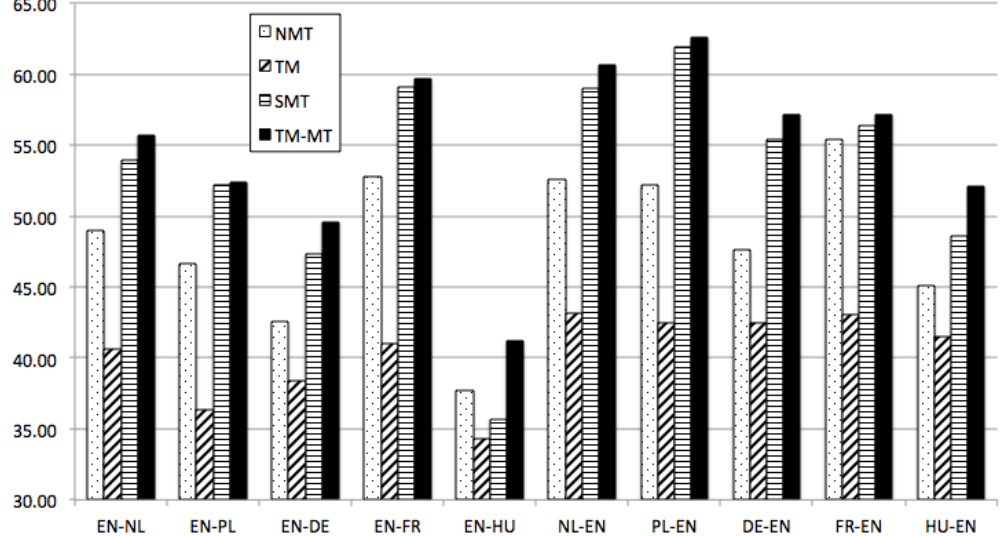
Figure 3. Overview BLEU scores TM-MT integration and baselines